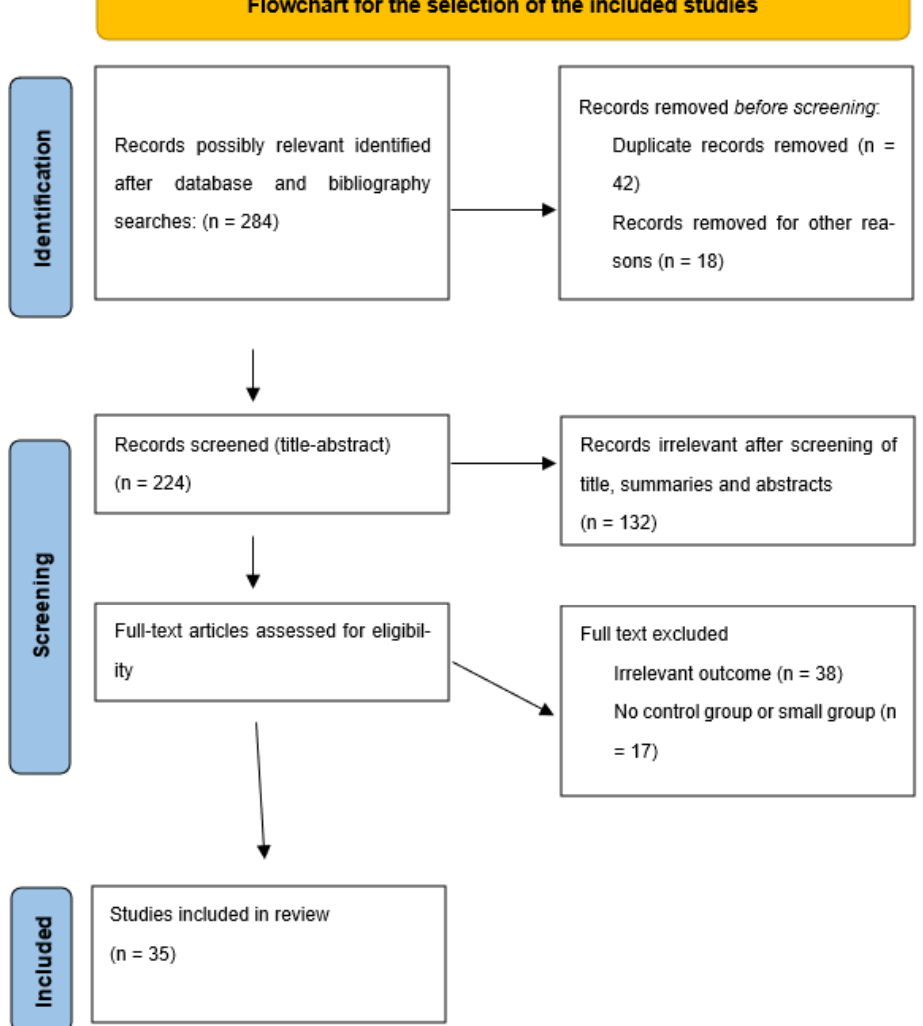
Figure 1. Flowchart of the selection of the included studies.